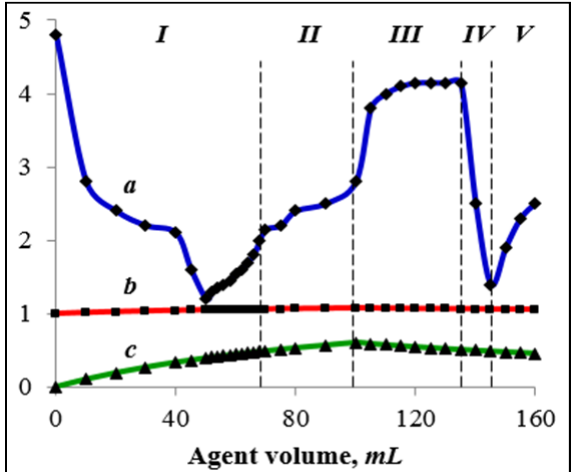
Figure 6. Electrochemical features